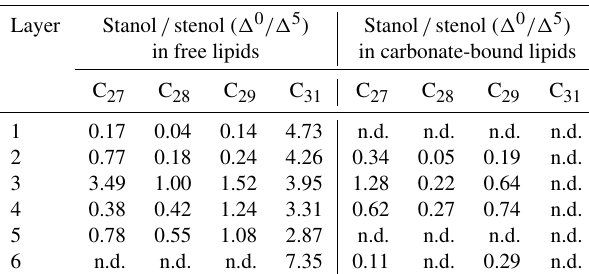
Table 3. Stanol / stenol ratios in the freely extractable lipids and carbonate-bound lipids for the microbial mat layers (n.d. is not de- termined, due to a very low concentration of